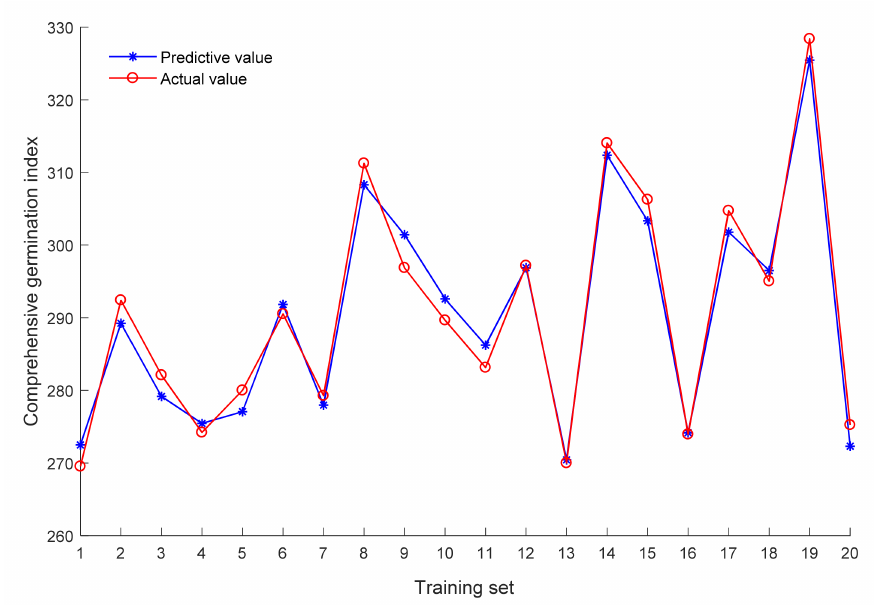
Figure 4. Training results of hybrid WOA–SVR for seed comprehensive germination index.